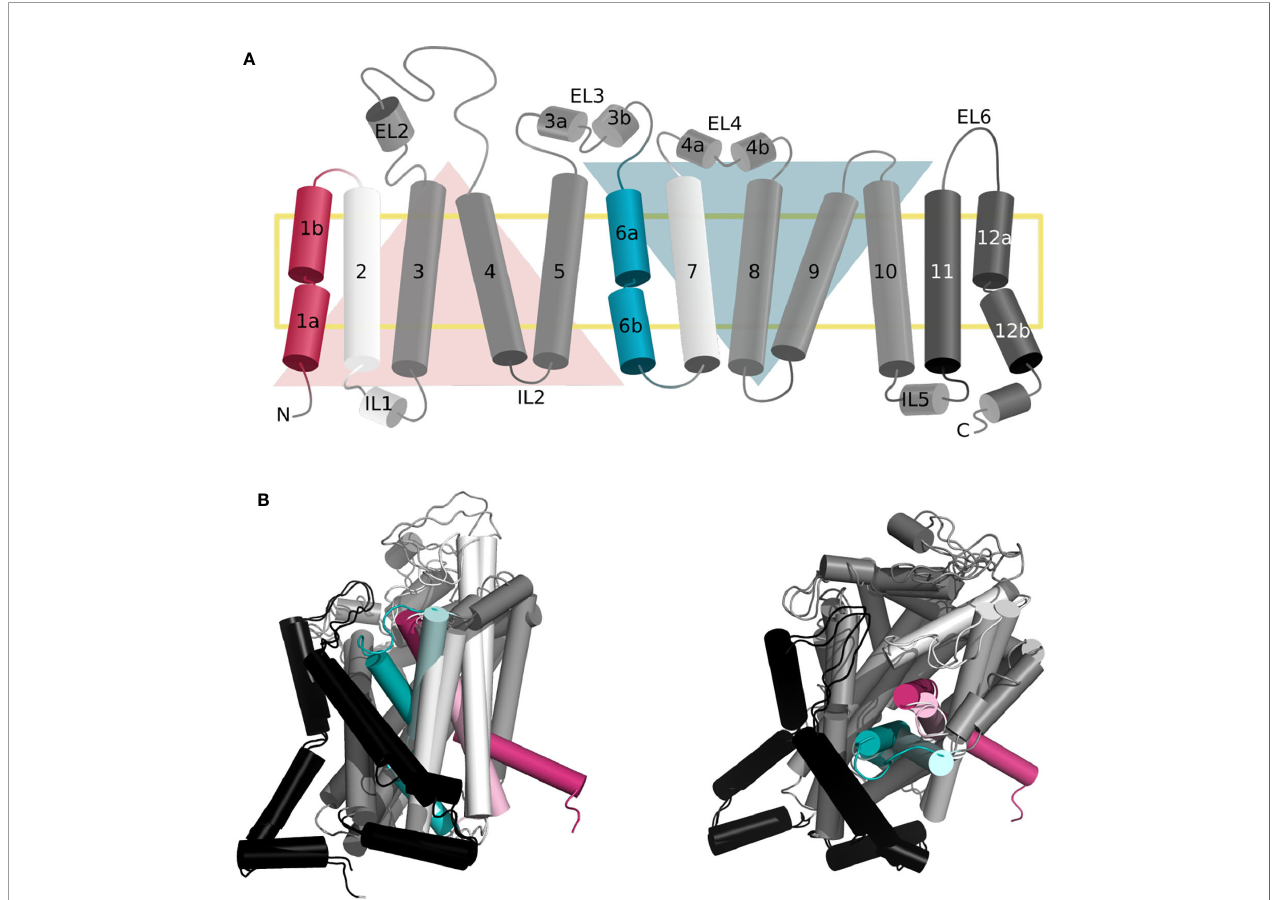
FIGURE 1 | Topology of the gated pore mechanism of transport. (A) Topology of hSERT. The transmembrane helices constituting the bundle and scaffold domain are shown in white and dark gray, respectively, with the exception of the gating helices TM1 and TM6 in red and cyan. The two inverted repeats are indicated by two triangles, while the two additional helices TM11 and TM12 are shown in black. This fi gure was adapted from ref (Hellsberg et al., 2019). (B, C) Superposition of the three-dimensional structures of hSERT in outward open [PDB ID 6DZY (Coleman et al., 2019)] and inward open [PDB ID 6DZZ (Coleman et al., 2019)] conformations from the side (B) and top (A) view, with the same color code as panel (A) the gating helices in the outward open conformation are shown in light red and light cyan, to contrast with the inward open